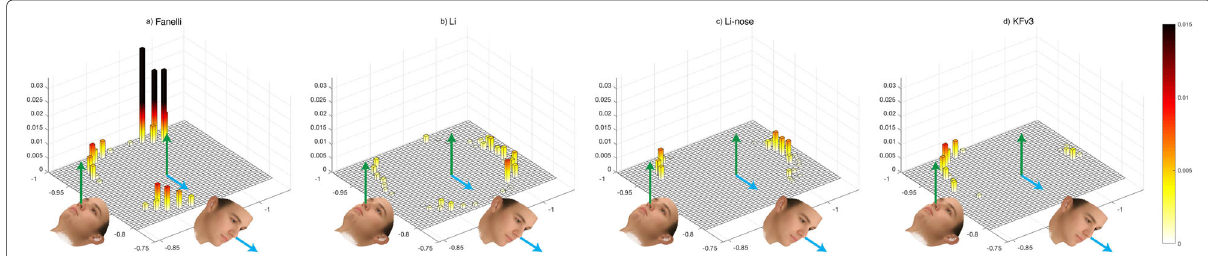
Fig. 15 2D histogram of the missed detection distribution on sequence BIWI 14. Results using a Fanelli, b Li’s approach, c Li’s proposal including of nose detection heuristic, and d our descriptor-based method,